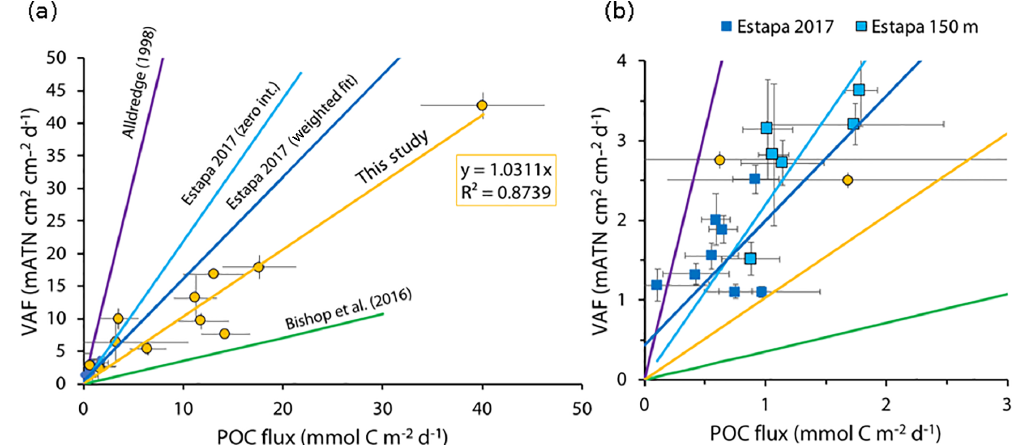
Figure 6. Regressions of volume attenuance flux (mATNcm 2 cm − 2 d − 1 ) to POC (mmol Cm 2 d − 1 ) for this study (orange points and line; y = 1 . 03 x , R 2 = 0 . 874) and Estapa et al. (2017, dark blue, weighted fit: y = 1 . 56 x + 0 . 434, R 2 = 0 . 632; light blue line, y = 2 . 191 x , R 2 = 0 . 47). The Bishop et al. (2016) estimated slope (green line) is y = 0 . 357 x (1 . 0 / 2 . 8). The Alldredge (1998) estimated slope (purple line) is y = 6 . 25 x . As this study’s calibration is created using samples collected at 150m, we separate out the Estapa (2017) data points collected at 150m by marking them in light blue for comparison. (a) The entire range of VAF and POC flux from this study. (b) Expanded graph near the origin ( x < 3mmol Cm − 2 d − 1 ) showing the range of Estapa et al. (2017) data.